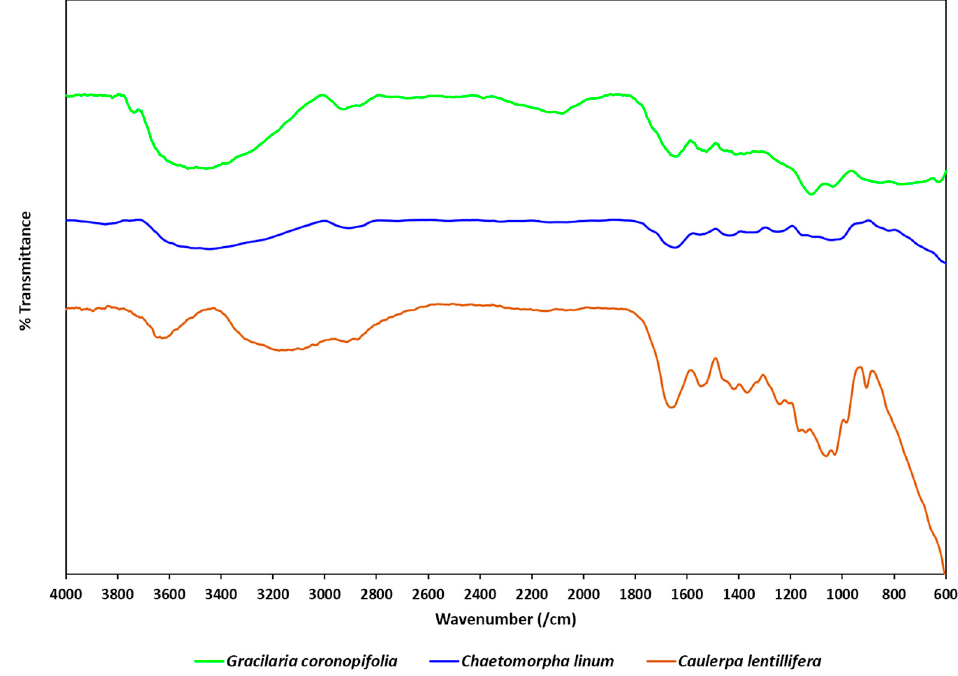
Figure 4. Spectra of algal biomass using FTIR analysis. Table 4. Typical band assignment of major peaks of algae